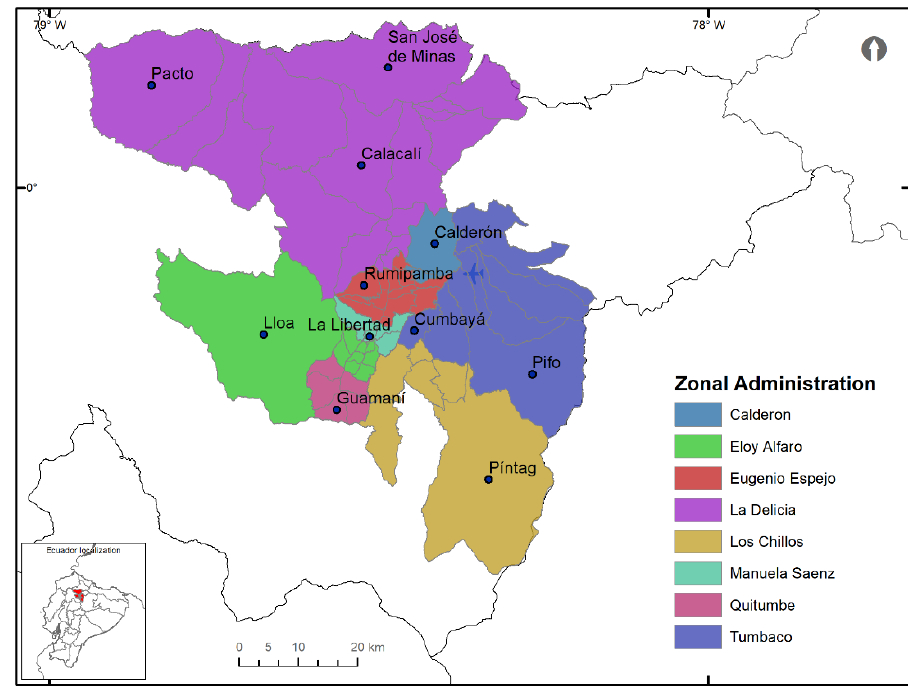
Figure 2. Administrative–political division of the